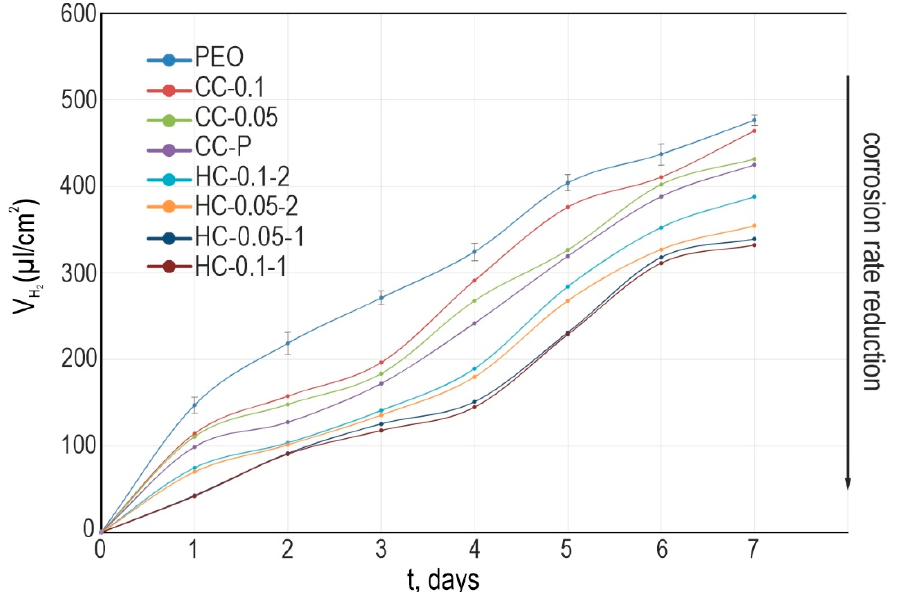
Figure 9. Change in normalized volume of evolved hydrogen ( V H protective layers during 7 days of exposure to HBSS. The errors for the measured parameters did not exceed 10 % (see the error bars for PEO).